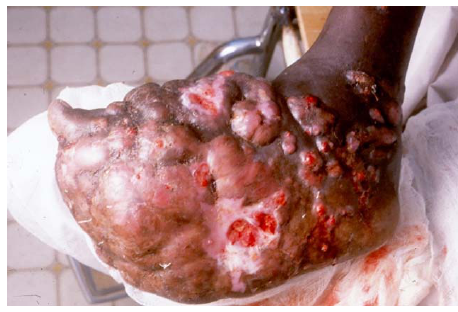
Figure 2. Massive actinomycetoma foot with multiple sinuses and discharge.